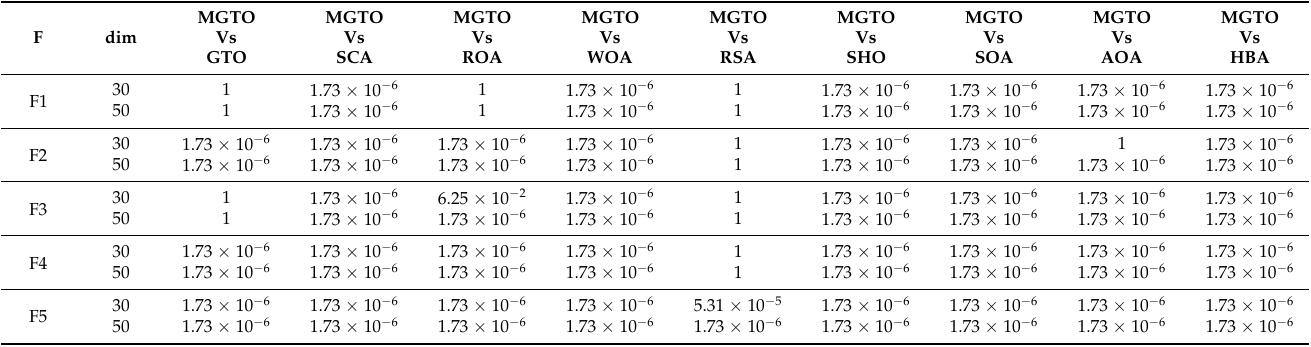
Table 4. Experimental results of the Wilcoxon rank-sum test on 23 standard benchmark